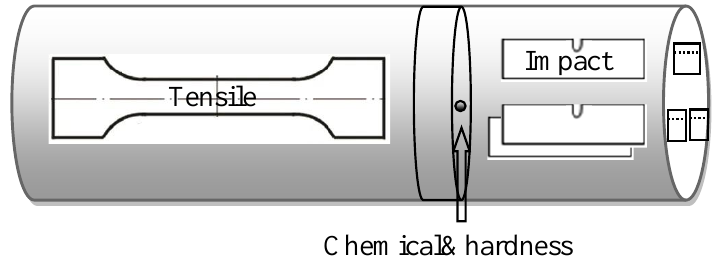
Figure 1. Carbon test sample.